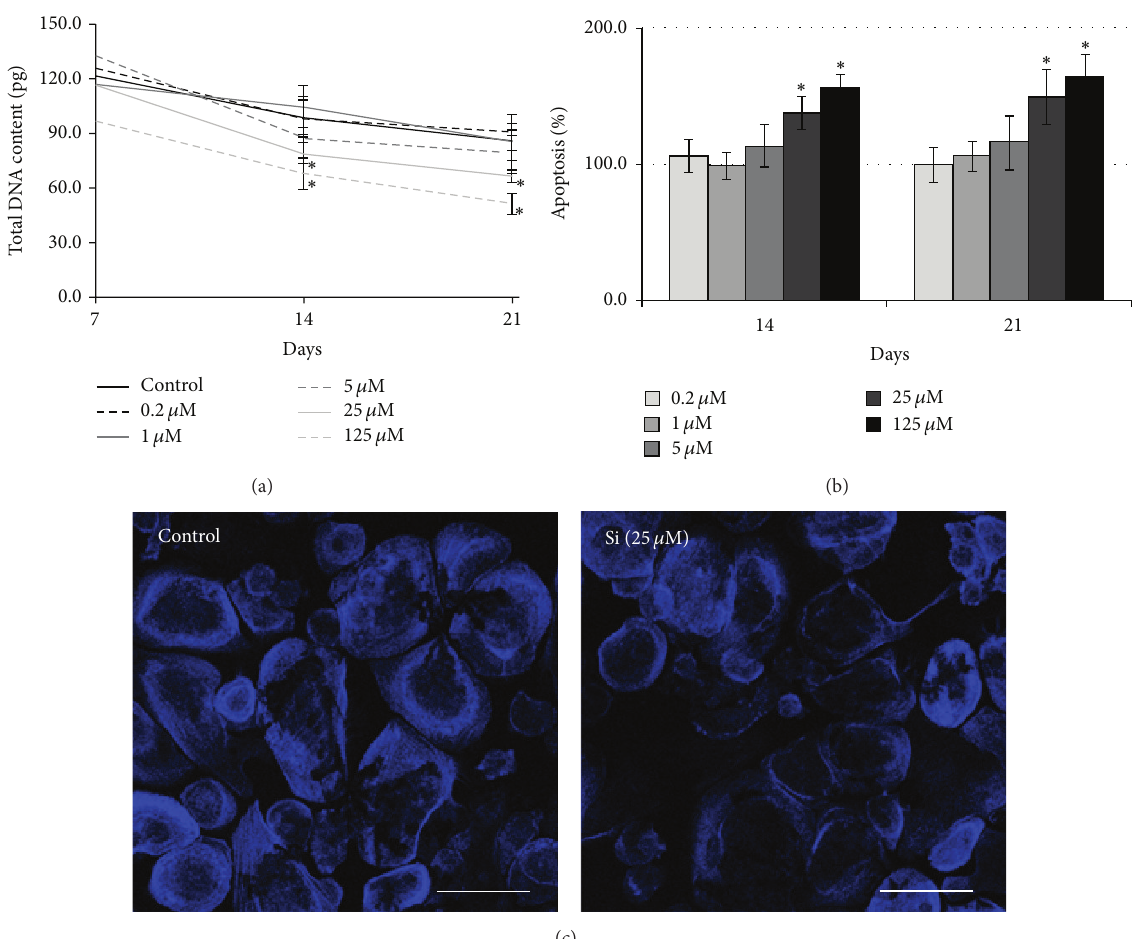
Figure3:EffectsofSioncelldensity,apoptosis,andmorphologyofCD14+cellcultures.(a)Cellulardensity,determinedbytotalDNAcontent; (b) apoptosis, determined by caspase-3 activity; (c) actin staining and visualization under confocal laser scanning microscopy. ∗ Significantly different than the control. White bars represent 150 𝜇